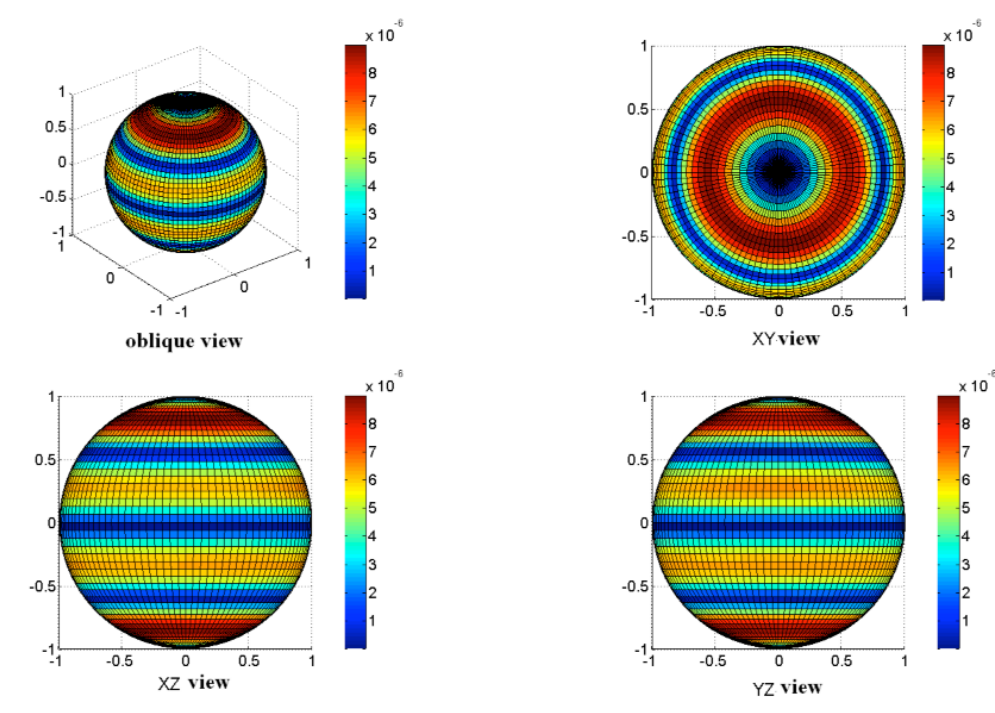
Figure 11. The distribution of on the sphere